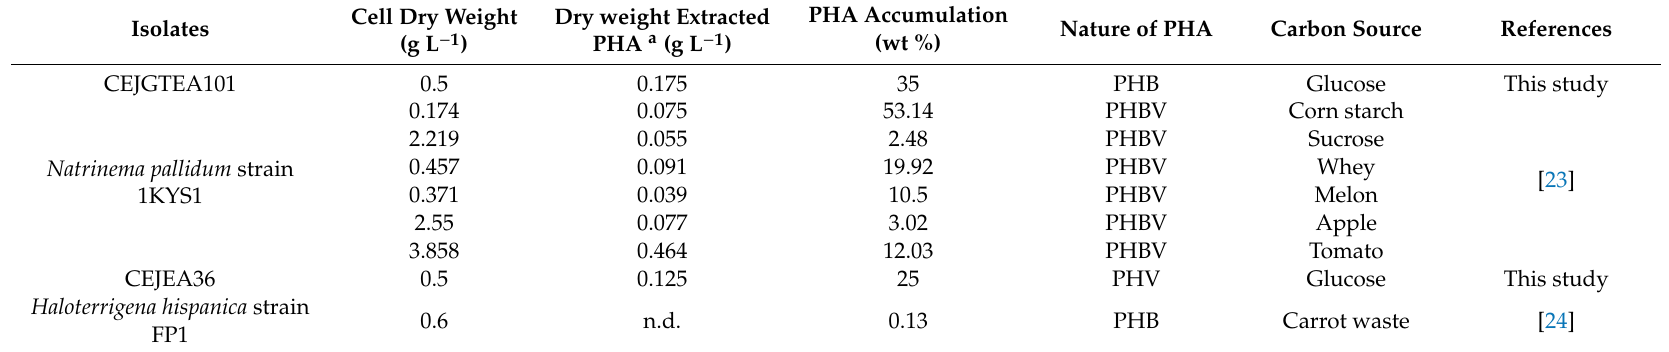
Table 2. Comparison of PHA production by two extremely haloarchaeal isolates CEJGTEA101 and CEJEA36 with closest phylogenetic